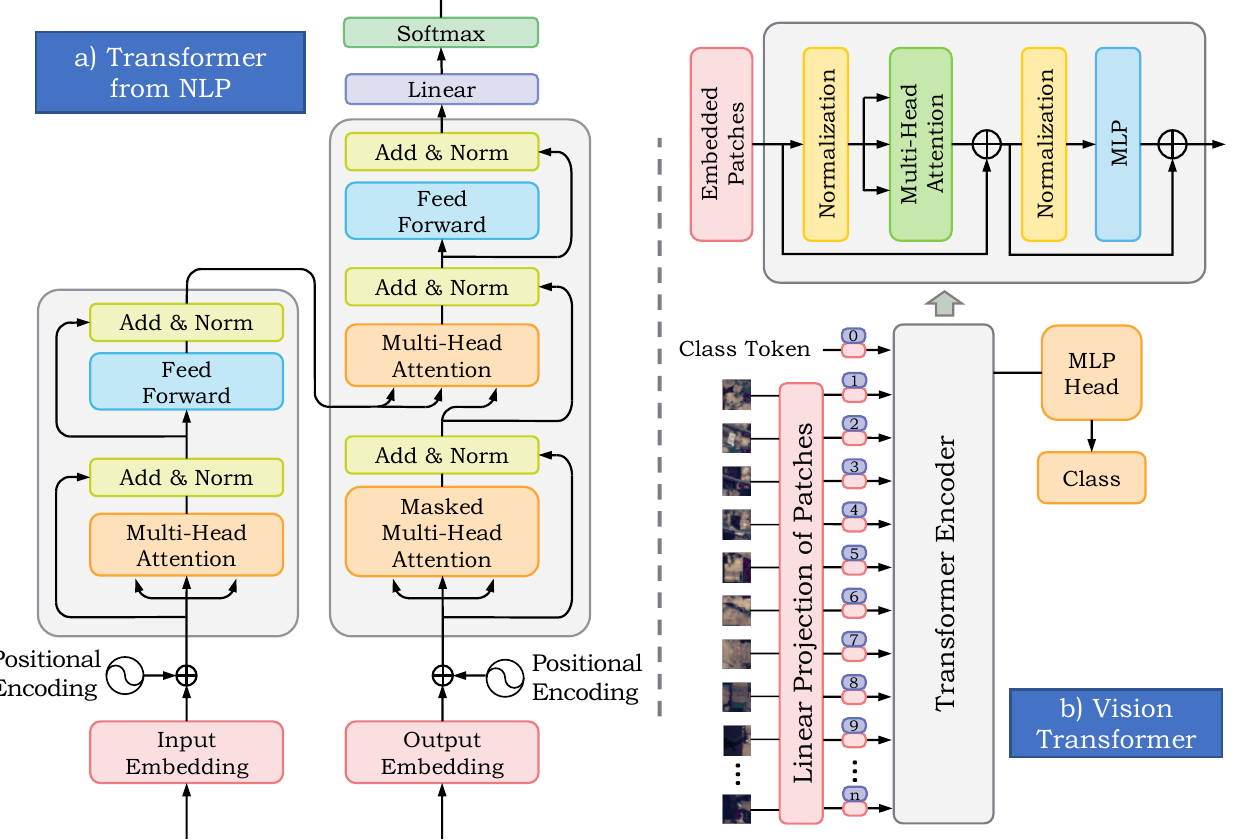
Figure 2. Illustration of ViT structure by sequence